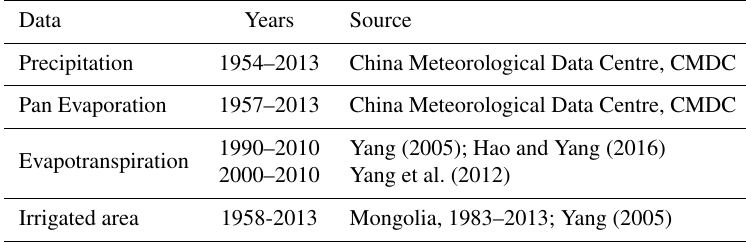
Table 2. Data sources used in this work.